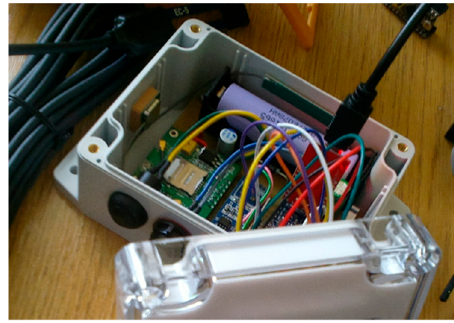
Figure 2. IoT node implementation.